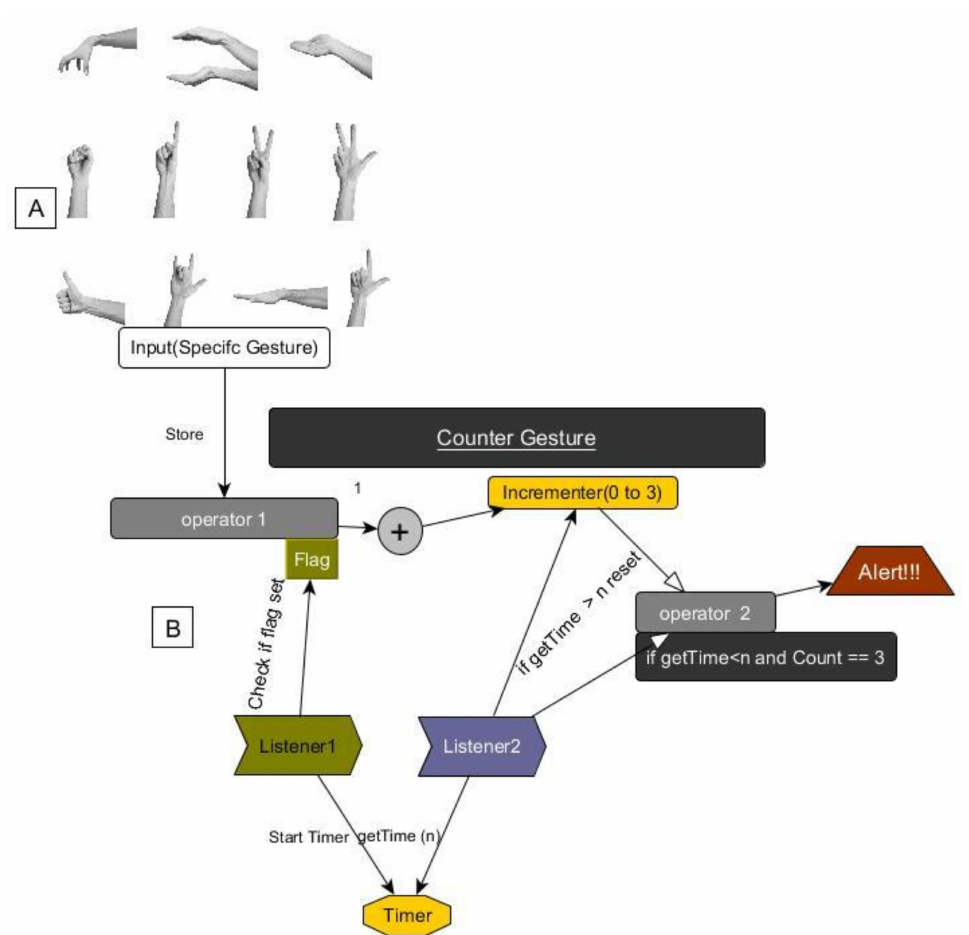
Figure 6. ( A ) Set of predefined images that the counterGesture considers. ( B ) In case the classifier identifies one of these gestures, the counterGesture will increment its counter up to 3 and trigger the alert, if there are at least three occurrences of the predefined